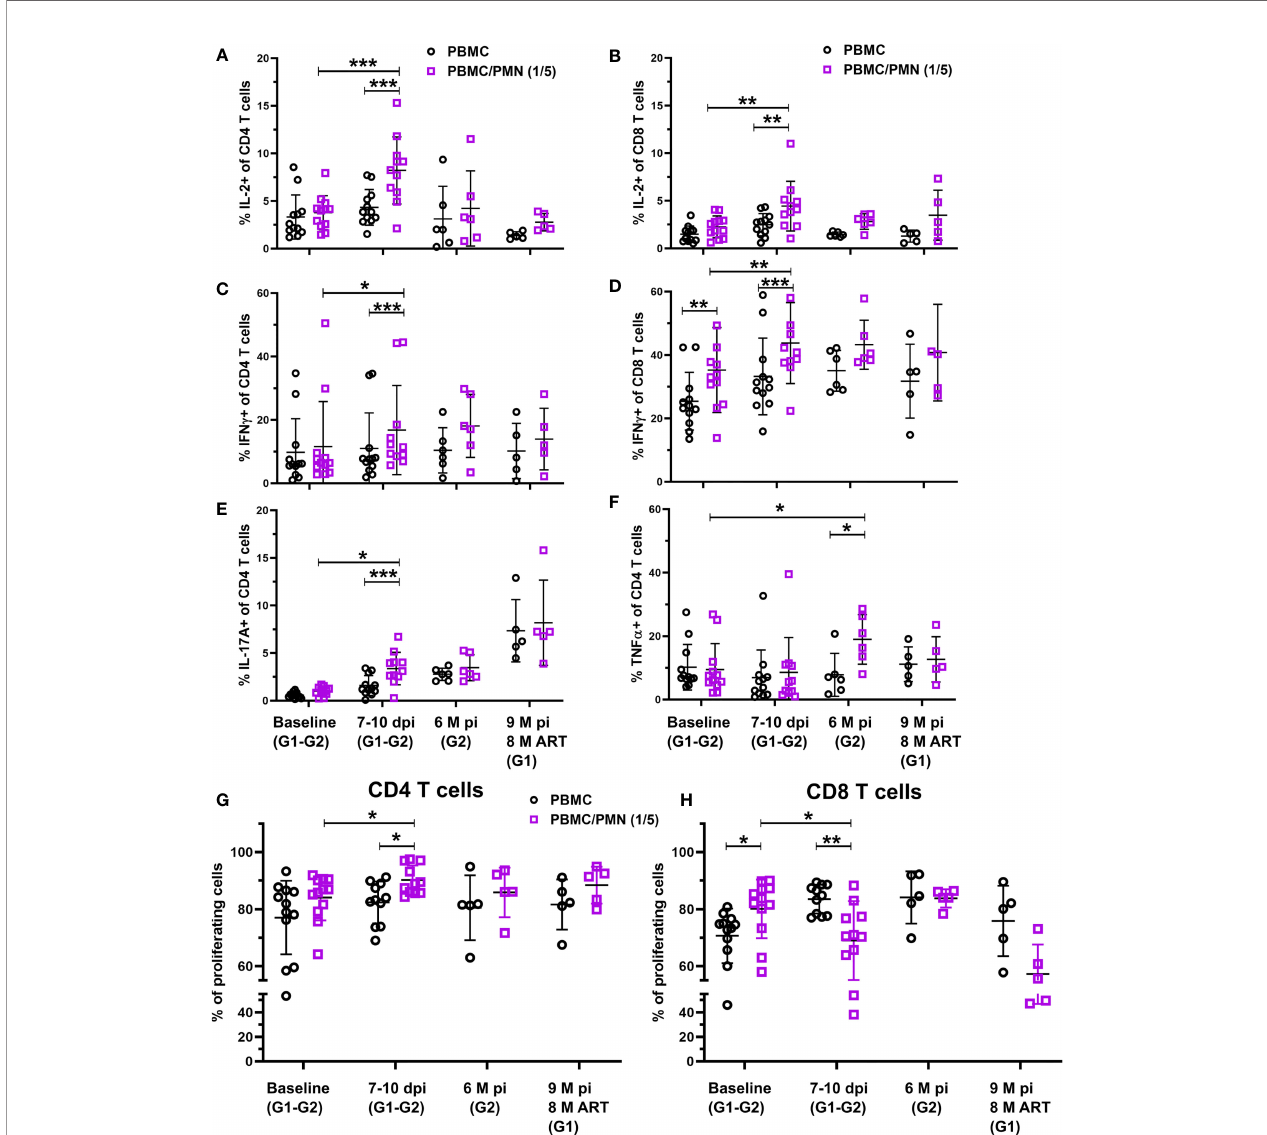
FIGURE 4 | T-cell immunomodulation by neutrophils during SIV infection. (A – F) PBMC were cultured for 16 h with a TCR stimulation, with or without PMNs at a 5:1 PMN to T-cell ratio. T-cell cytokine production was measured by intracellular cytokine staining of IL-2, IFN-g, TNF-a, and IL-17A after co-culture. Graphs represent the frequency of CD4 + or CD8 + T cells positive for each cytokine in the absence (black) or presence of PMNs (purple). (G, H) PBMC were cultured for 96 h with or without PMNs at a 5:1 PMN to T-cell ratio and T cell stimulation. T-cell proliferation was measured by CFSE dilution and the populations identi fi ed by fl ow cytometry. Graphs represent the frequency of CD69 + CD4 + T cells and CD8 + T cells with CFSE dilution. *p < 0.05, **p < 0.01, ***p < 0.001 by Wilcoxon or Mann-Whitney tests depending on pairing. Baseline: Groups 1&2, Acute week 2: Groups 1&2, Chronic: Group 2 (6 M p.i.), Chronic cART: Group 1 (7 M p.i., 6M